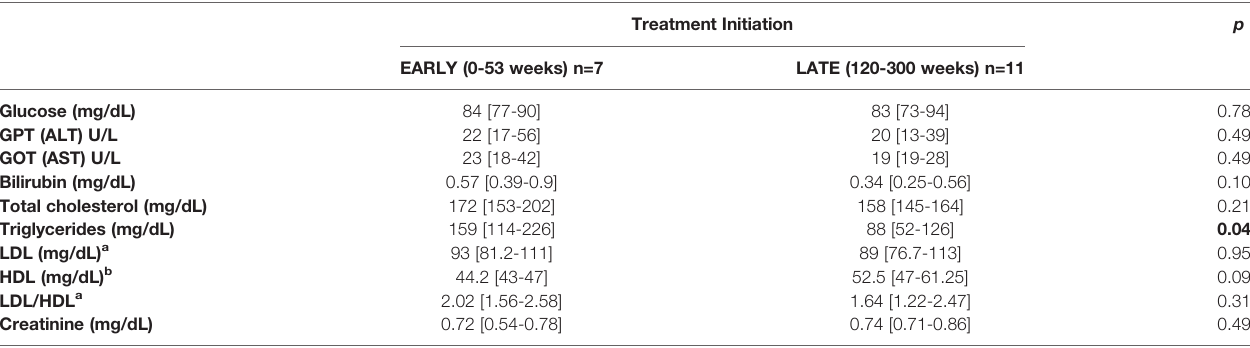
TABLE 2 | Biochemical and in fl ammatory